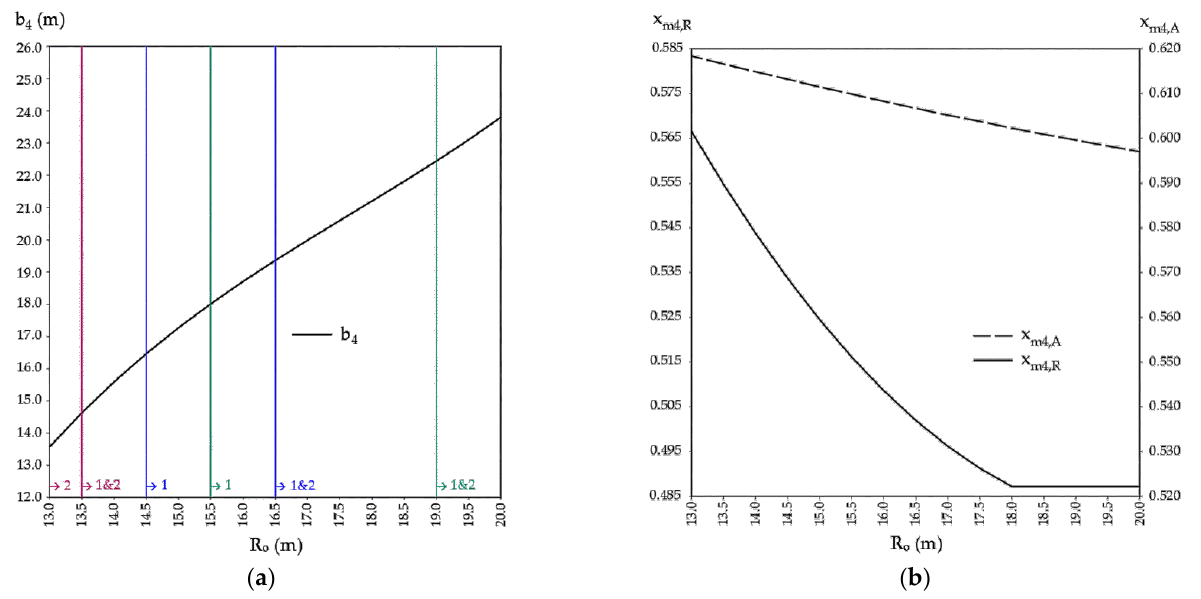
Figure 12. Investigated parameters at leg 4 as a function of R o for different δ, considering the application of design conditions 1 and 2: ( a ) geometric parameter b 4 ; ( b ) traffic parameter x m4 .